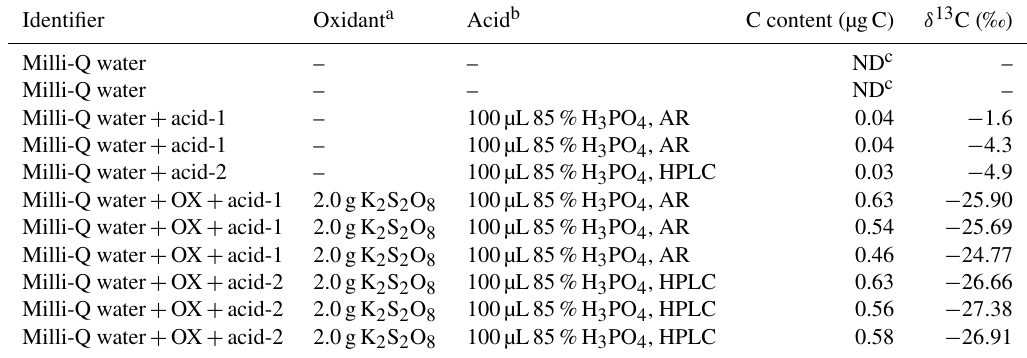
Table 1. Various blank preparations and